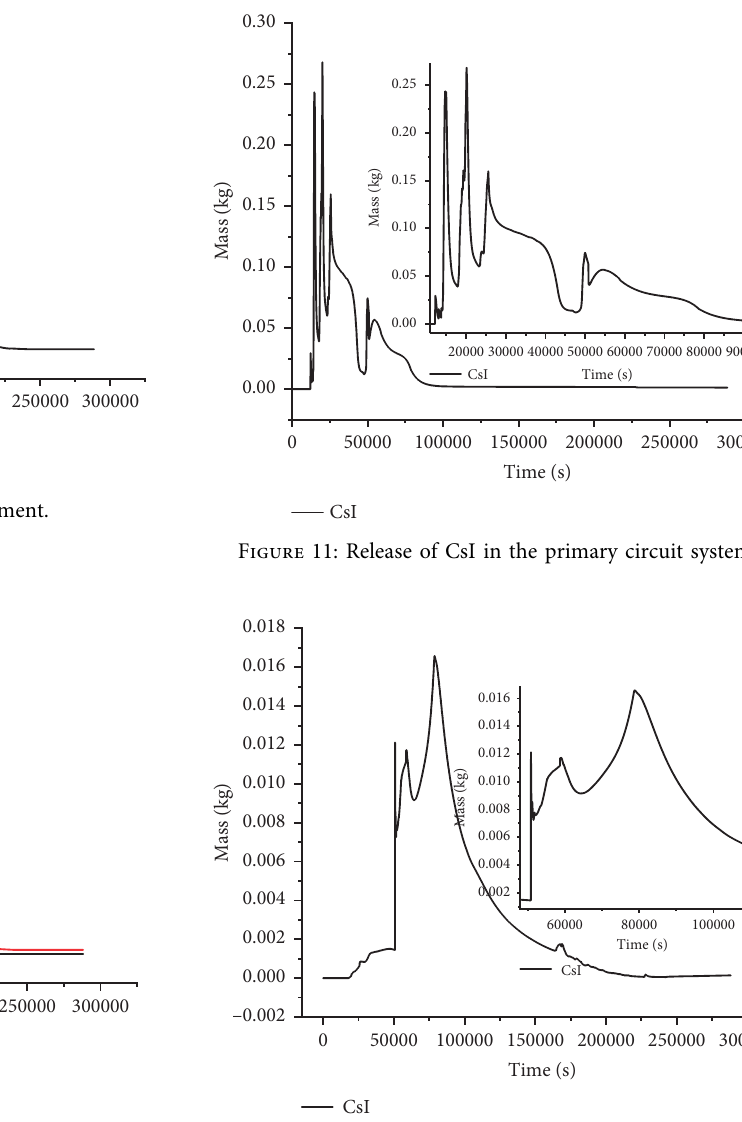
Figure 10: Comparison of I and CsI.